Question: What kind of plot is shown here?
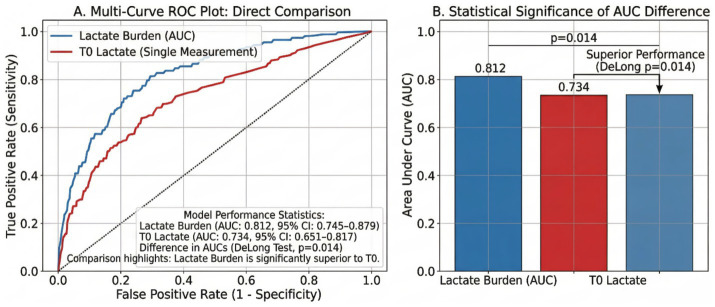
Answer: bar